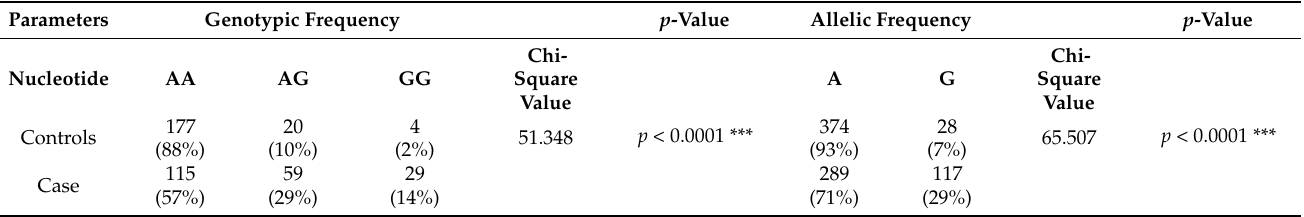
Table 2. Genotype and allelic frequency distribution at single nucleotide polymorphism rs1695